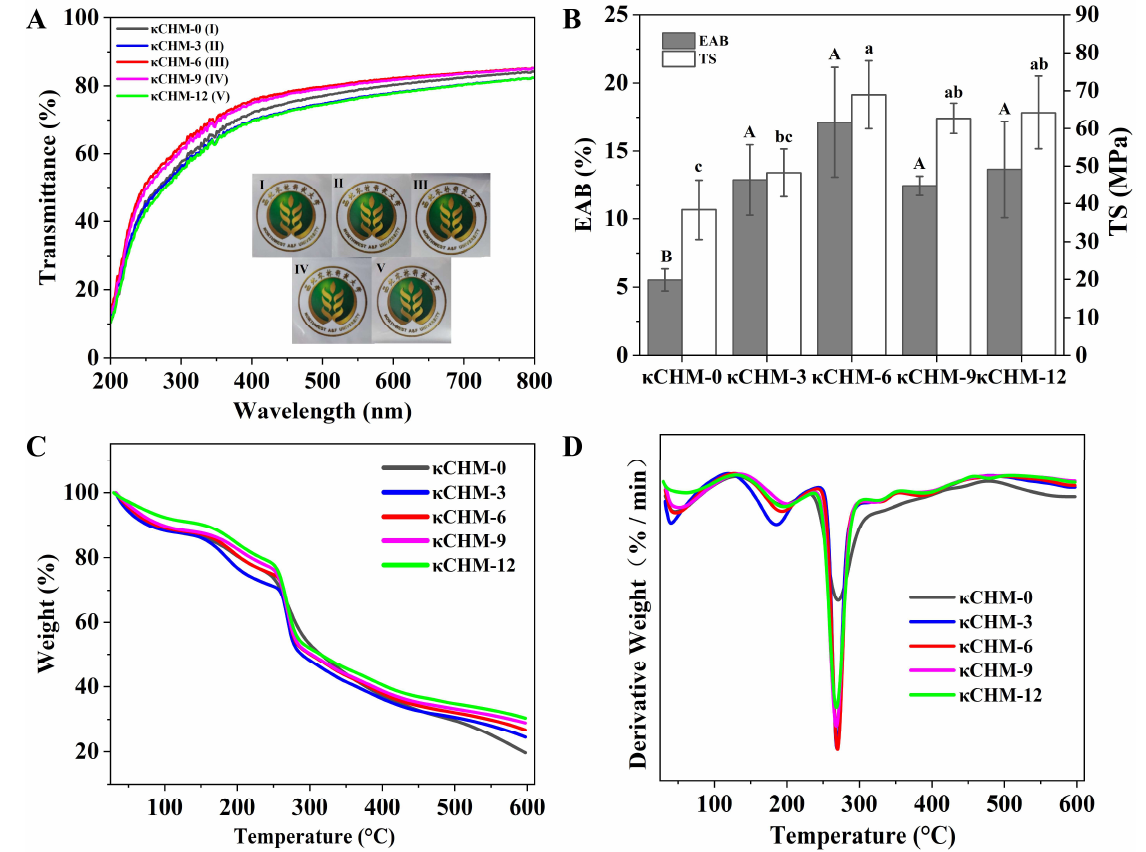
Figure 3. ( A ) Light transmittance, ( B ) mechanical properties, ( C ) TGA thermograms and ( D ) DTG curves of κCHM films. Abbreviations: TS, tensile strength; EAB, elongation at break. The data of TS and EAB are expressed as mean ± standard deviation with n = 5. Different letters for the same test parameter indicate significant differences among different groups ( p < 0.05). TS, tensile strength; EAB, elongation at break.